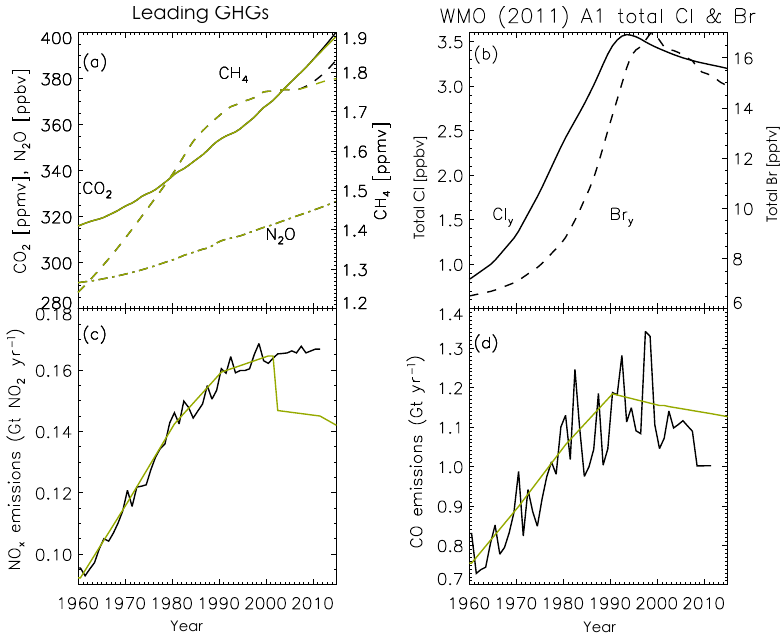
Figure 1. Time evolution of anthropogenic forcings used in CCMI simulations: (a) greenhouse gases (GHGs) volume mixing ratios, (b) total organic chlorine and bromine volume mixing ratios, (c) nitrogen oxide emissions (NO x ), and (d) carbon monoxide emissions (CO). Black lines denote forcings used in REF-C1, and lime lines for REF-C2. Note the discontinuity in NO x emissions ( c ) mentioned in the text.